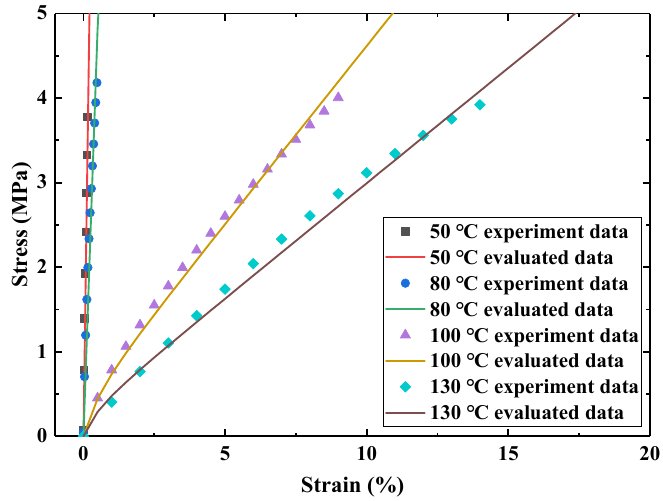
Figure 6. Evaluation curves of hyperelastic parameters at different temperatures. Table 1. Evaluation of neo-Hookean